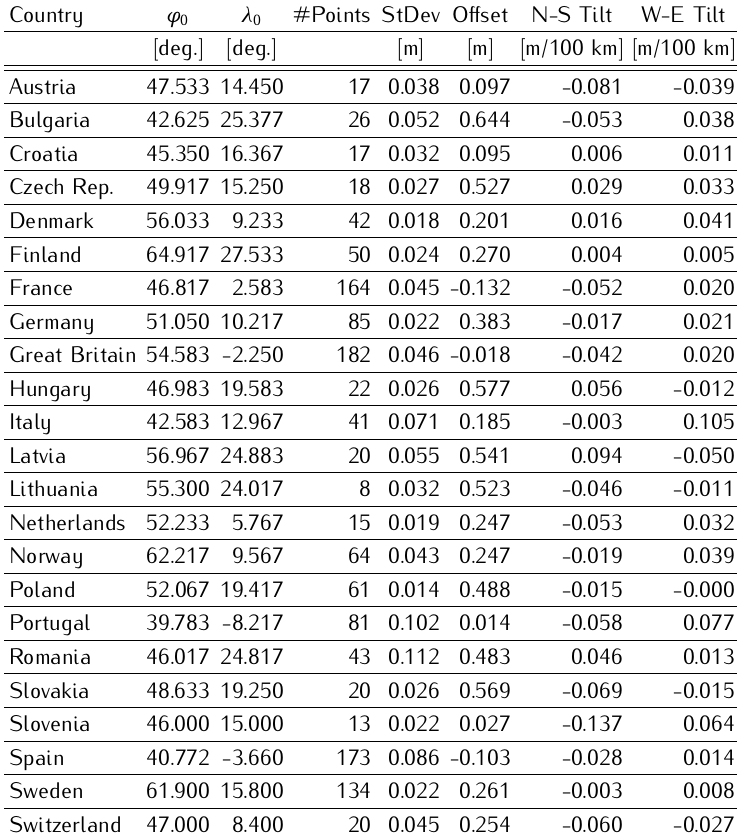
Table 3. Height reference frame unification in Europe using the GF approach based on the filter-combined GOCO03S+EGG2008 gravity field model: Estimated offsets and slopes. All values refer to U 0 GRS80 and are computed in the zero-tide